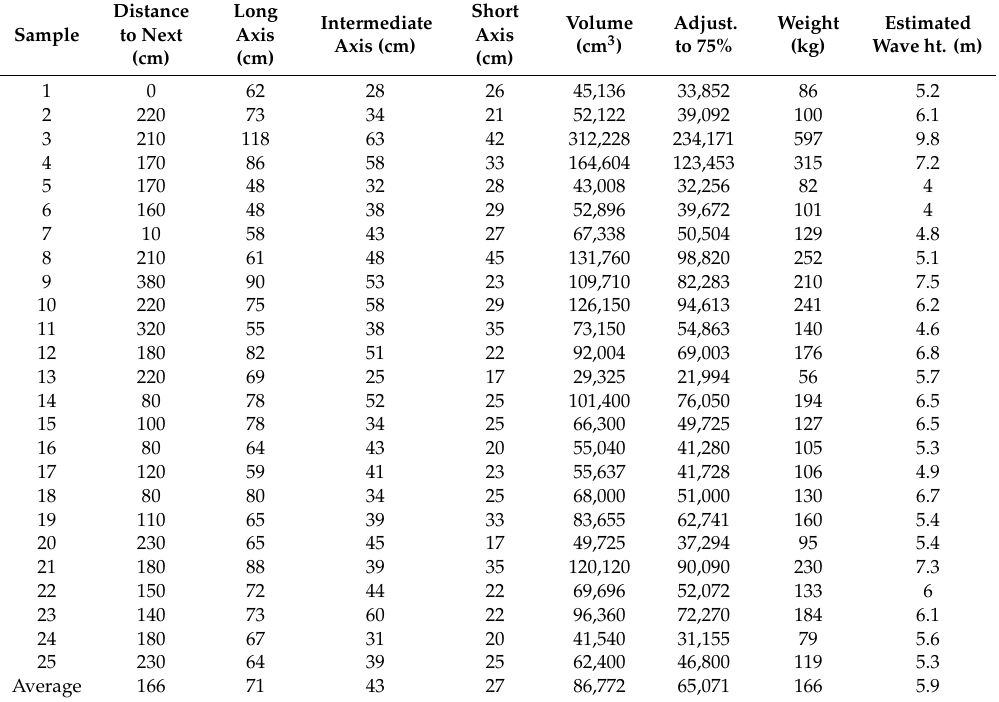
Table 5. Quantification of boulder size, volume and estimated weight from coastal bar samples collected from transect 2a. (north of Cerro Enfermer í a). The laboratory result for density at 2.55 gm / cm 3 is applied uniformly in order to calculate wave height for each boulder.